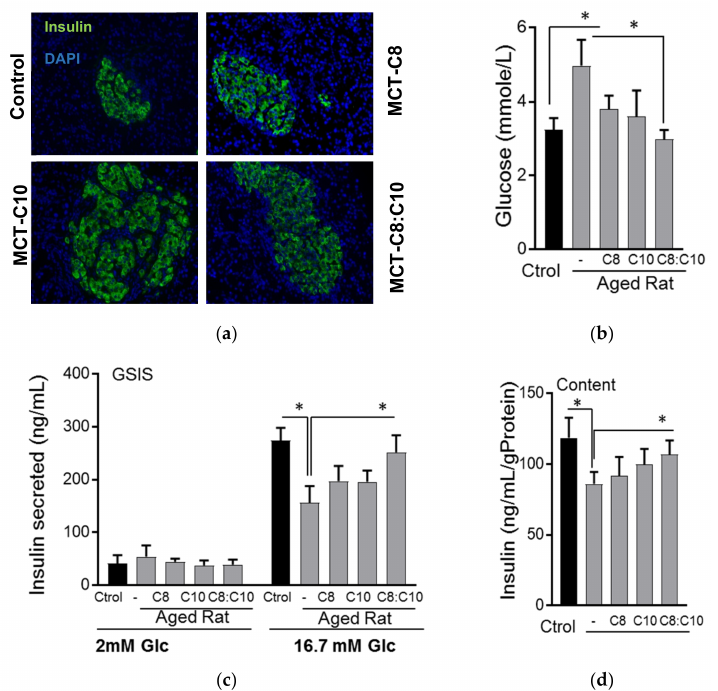
Figure 1. Medium chain fatty acids improved β -cell function in aged rats. ( a ) Immunohistochemical staining of pancreas with insulin from aged rats fed with normal chow diet supplemented with sunflower oil (Ctrol), octanoic acid (C8), decanoic acid (C10) or a 40:60 mixture of octanoic acid: decanoic acid (C8:C10) medium chain triglycerides for 8 weeks. ( b ) Fasting glucose ( n = 12), ( c ) i secretion